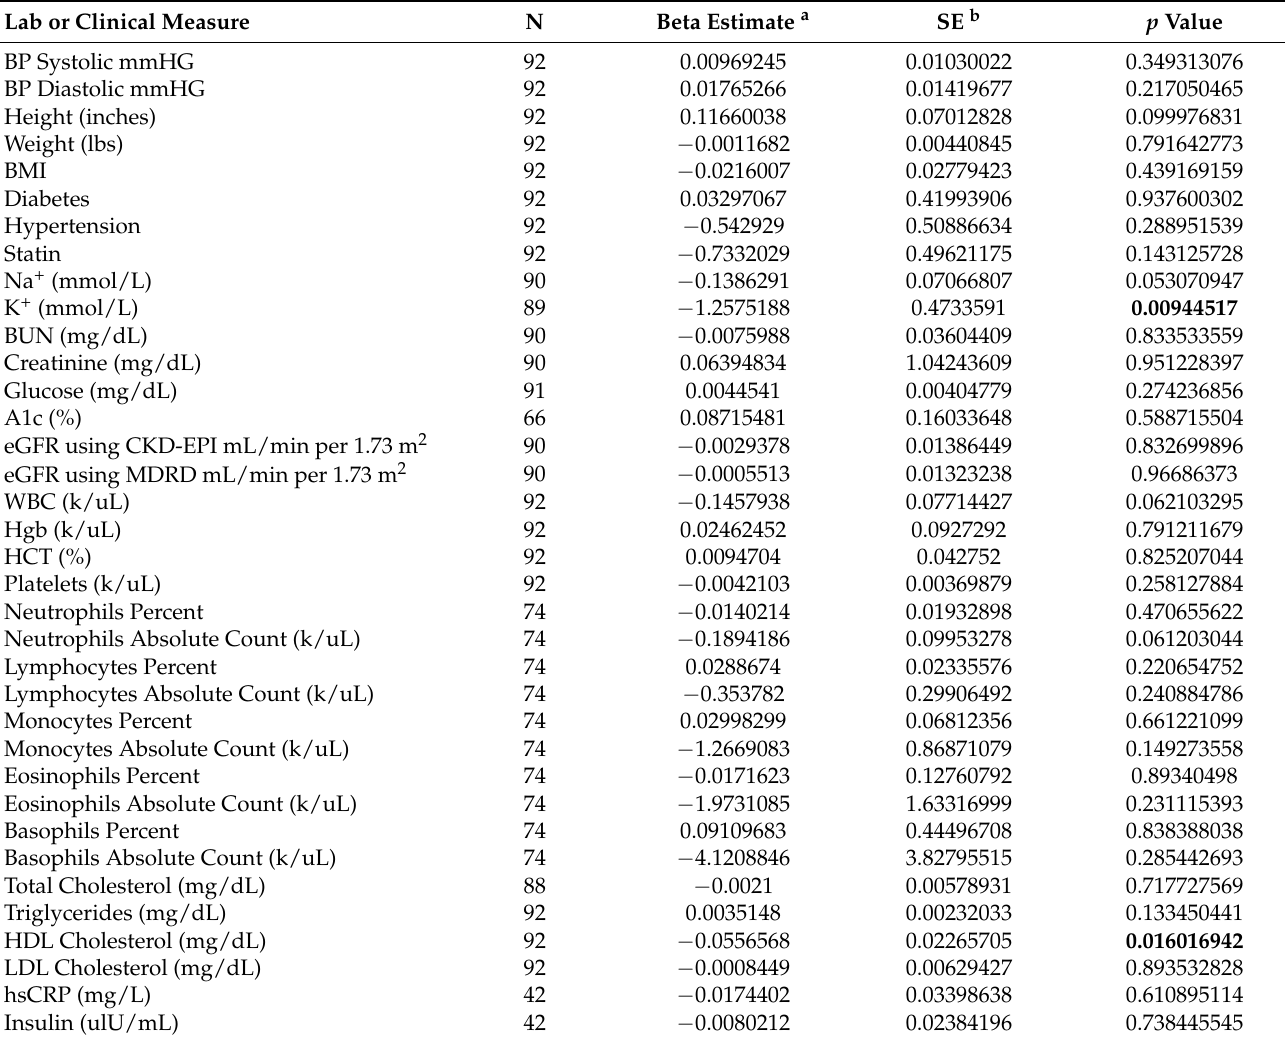
Table 1. Regression analysis of associations of serum RCN2 concentrations with clinical and lab measures in the CAVA cohort.